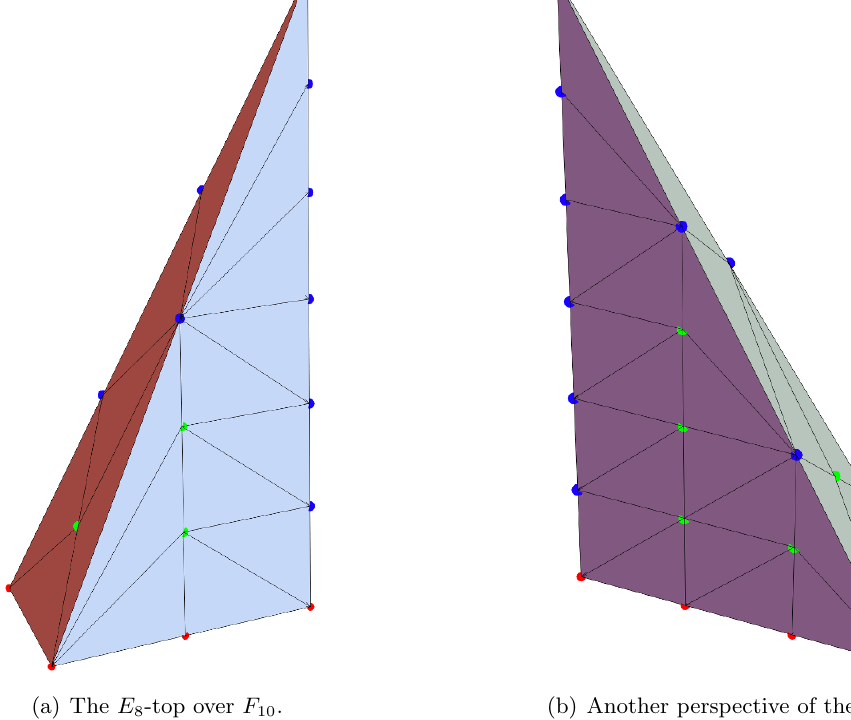
Figure 2 . A visualization of the E 8 -top over F 10 . The vertical direction is x 3 . At x 3 = 0, the red points are the lattice vectors of F 10 . For x 3 > 0, the blue points represent the vectors of the exceptional divisors of the E 8 , as they sit on the edges of the top. The green points are facet interiors and correspond to non-(cid:13)at surfaces. Di(cid:11)erent facets encode the local geometry at di(cid:11)erent non-(cid:13)at (cid:12)bers. The triangulation shown in the (cid:12)gures is arbitrary; for the rank one sector it de(cid:12)nes the dP 1